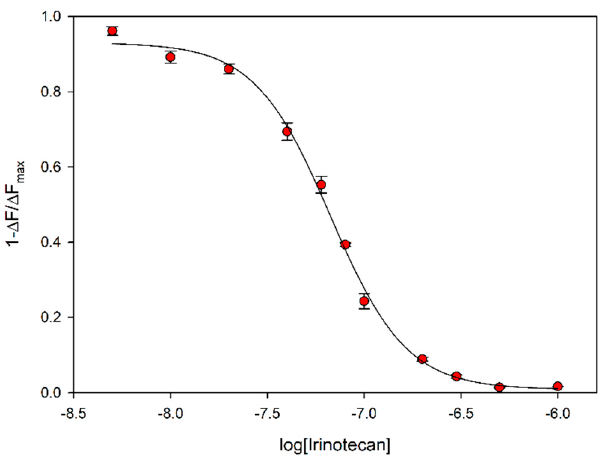
Figure 6. Fluorescence decrease of 60 µ g / mL MIP F at increasing concentration of irinotecan in 3:1 acetonitrile:human plasma. The decrease is reported as the fraction of the maximum one.